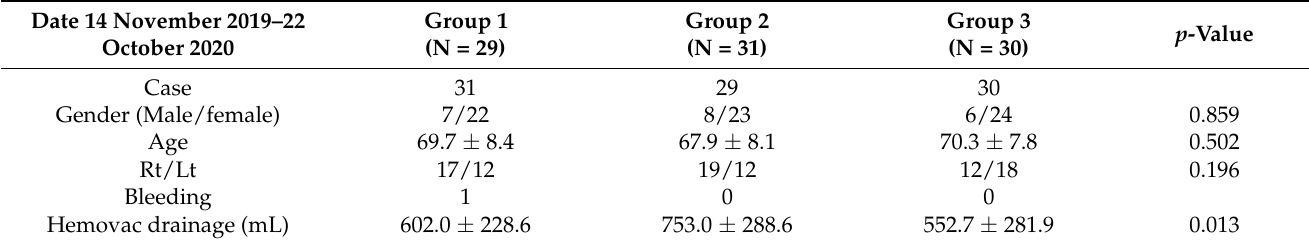
Table 1. The baseline characteristics of the three groups in this study.